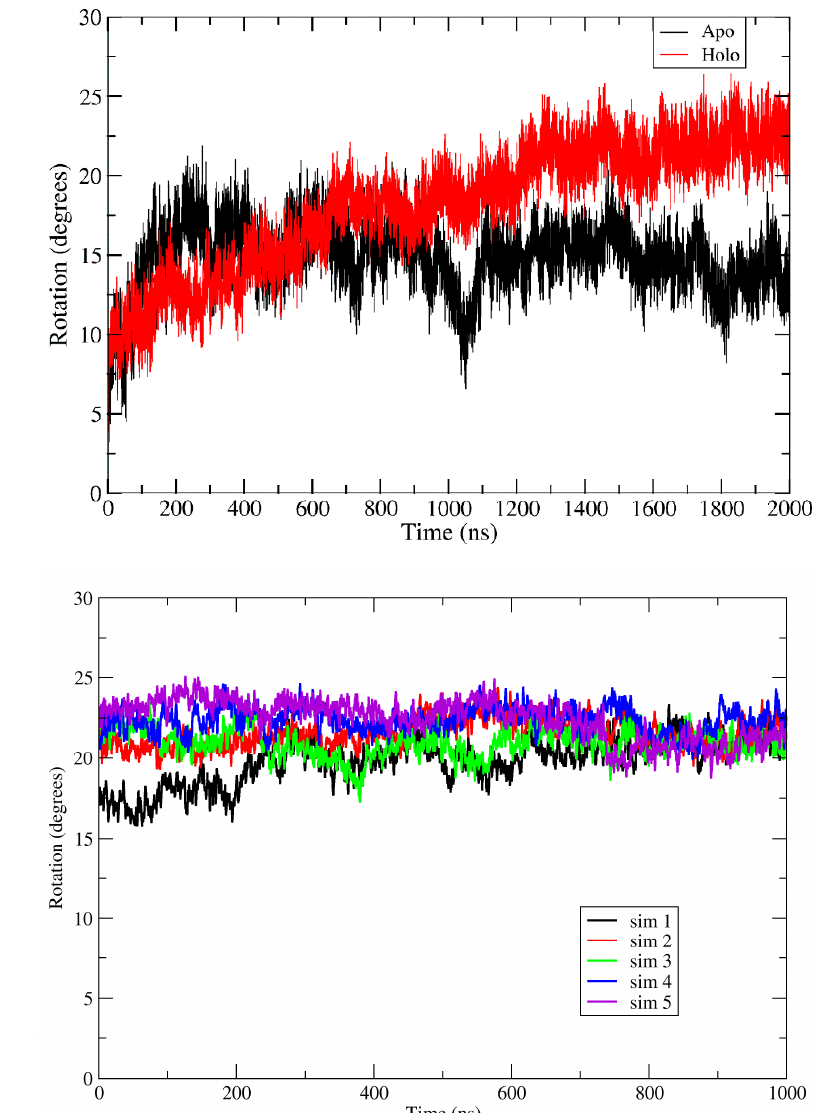
Figure 4. Global rotational shift of BsArgR. ( A ) Each initial structure (0 time) undergoes a very fast initial rotational shift of ~10 degrees, then evolves by further rotation, reaching a mean value of rotation during the last 500 ns of the equilibrated part of the trajectories of 14 ± 1.4 (mean ± std. deviation) degrees for apoBsArgR and 22 ± 1.3 degrees for holoBsArgR. Rotation angle is calculated as depicted in Figure S6. As described in the text, the variance observed in each time course is uncoordinated motions of each subunit, not rotational oscillation of trimers. ( B ) Sim 1 represents the equilibrated holoArgR simulation from 1–2 us from panel A but with averaging over a 1-ns window. Sims 2–5 are replicas of that simulation starting from the equilibrated holoBsAgR conformation, each averaged over a 1-ns